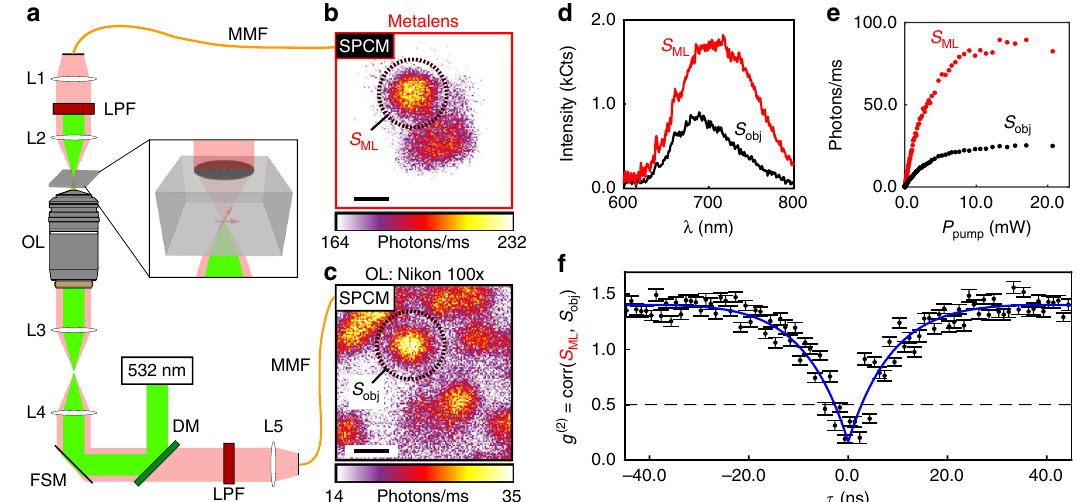
(cid:3) ( n s ) Fig. 4 Imaging an individual NV center. a Experimental setup. MMF = multimode fi ber, LPF = long-pass wavelength fi lter, OL = objective lens, FSM = fast- steering mirror, DM = dichroic mirror, SPCM = single-photon counting module, L1-L5 are achromatic lenses. b PL signal from the metalens when the 532-nm pump beam is rastered. c confocal PL image from the objective recorded simultaneously with b . Scale bars in b and c denote 500 nm d , PL spectra, and e , saturation curves of the metalens and objective signals, S ML and S obj , corresponding to the spot circled in b and c , respectively. f Intensity cross- correlation between S ML and S obj , con fi rming that the spot measured in both images is an individual NV center. The dashed line represents the single- emitter threshold. Measurements in d – f are background corrected. Error bars in f represent the Poisson uncertainty in each bin of the correlation